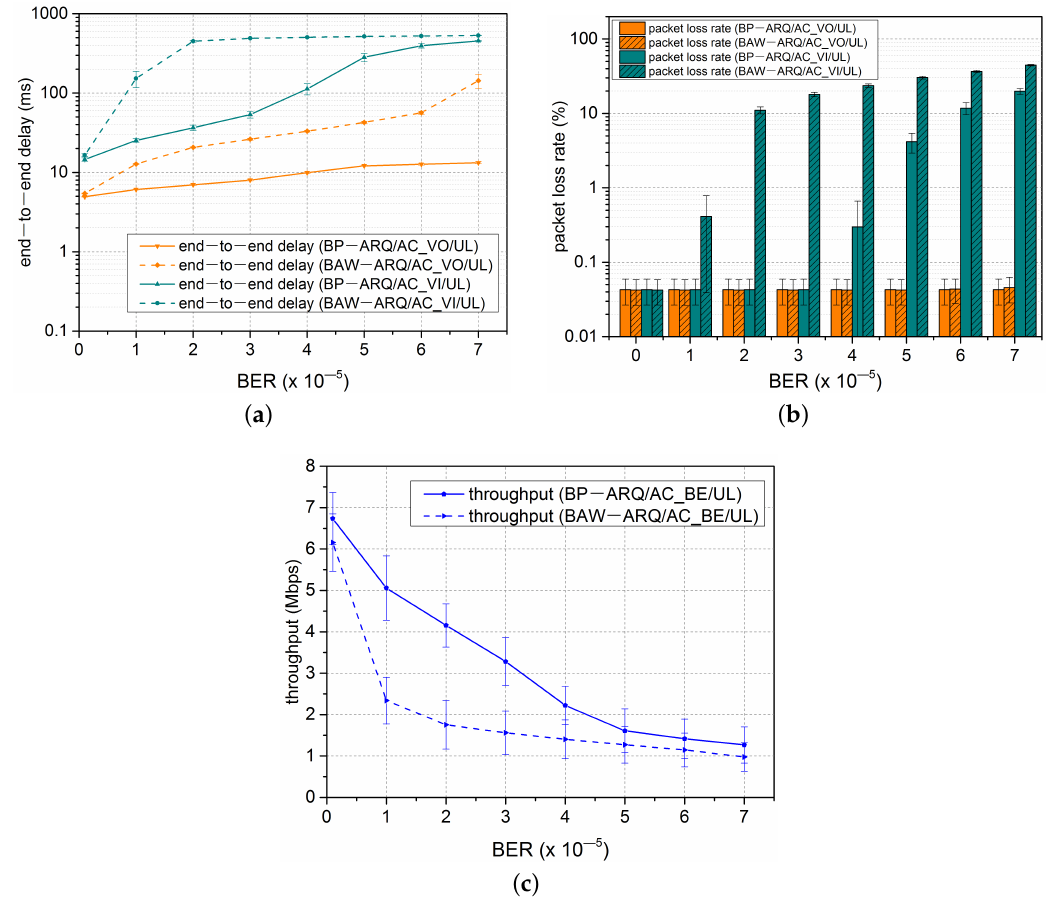
Figure 15. The QoS performances vs. the BER in the uplink . ( a ) The end-to-end delay of the AC_VO and AC_VI traffics. ( b ) The packet loss rates of the AC_VO and AC_VI traffics. ( c ) The throughput of the AC_BE traffic in each